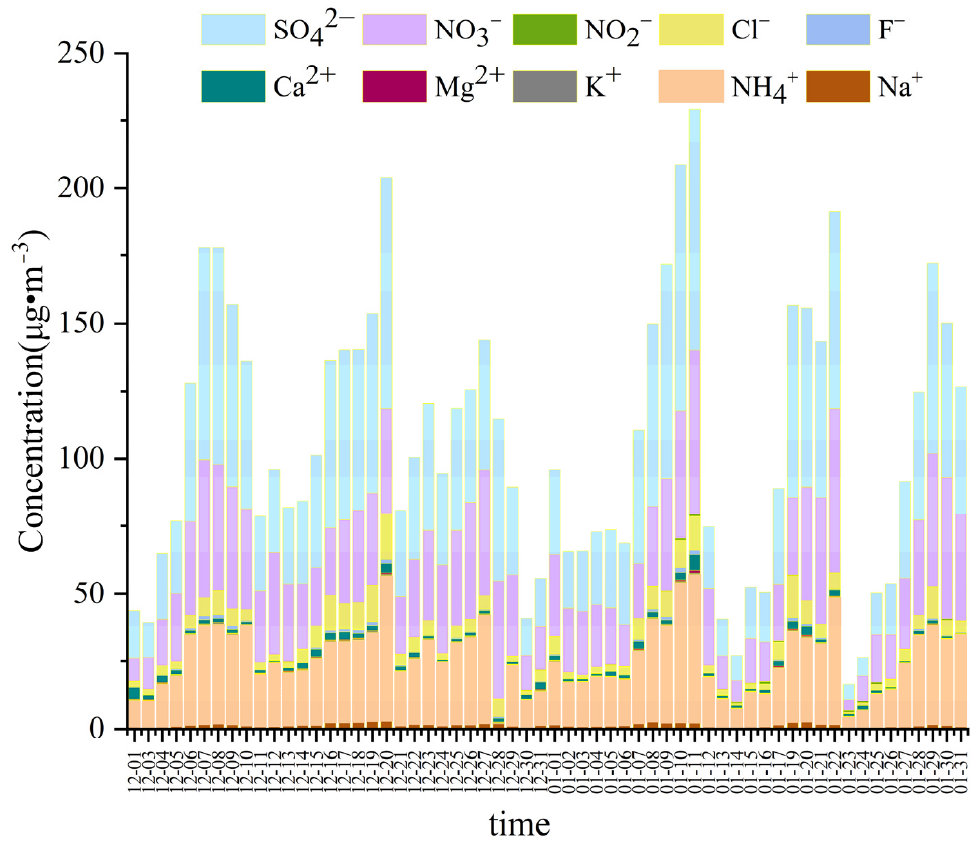
Figure 3. Diurnal variation of mass concentration of water-soluble inorganic ions (WSIIs) in PM 2.5 in Shihezi in winter. Table 1. Mean concentrations of WSIIs sampled in Shihezi compared with the data from other cities in China ( µ g/m 3